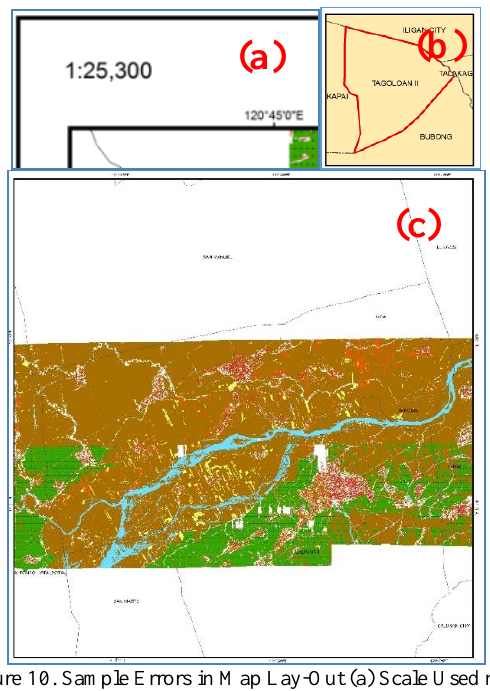
Figure 10. Sample Errors in Map Lay-Out (a) Scale Used not a Multiple of 500, (b) Index Map not Showing Adjacent Municipalities, and (c) Data Frame not Showing All Classified LiDAR Coverage